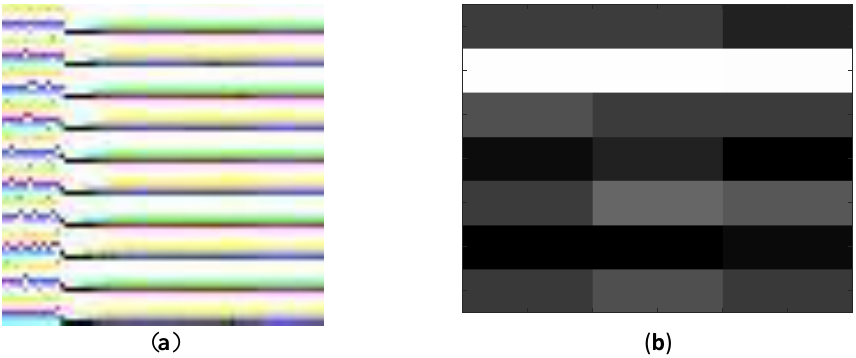
Figure 2. ( a ) An example of 70 by 70 generated RGB tactile image from the BiGS (BioTac Grasp Stability) dataset, and ( b ) an example of 7 by 3 instantaneous electrode reading.